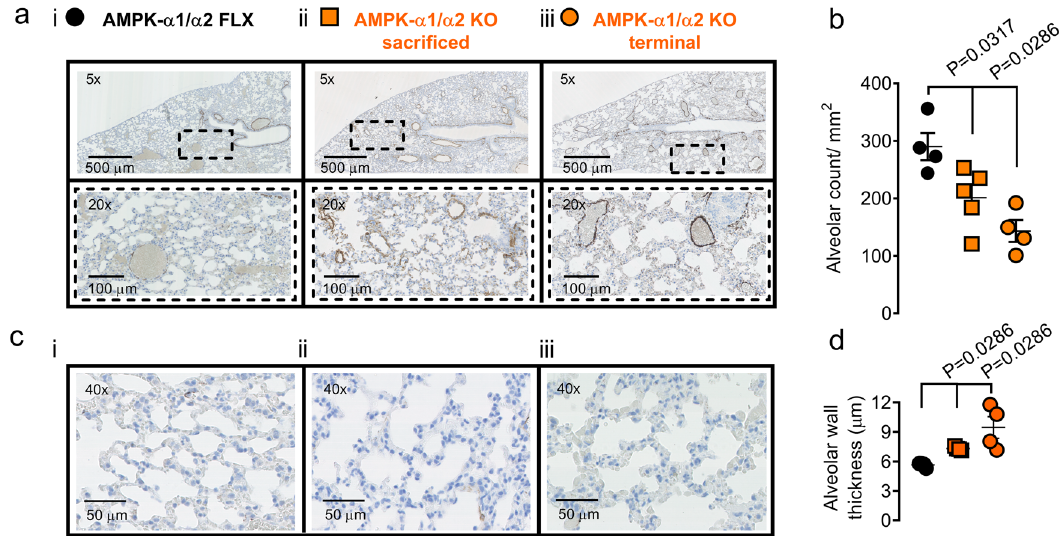
Fig. 4 | AMPK- α 1/ α 2 deletion reduces alveolar number and precipitates thick- ening of alveolar walls. a Representative images of alveoli in lung slices from terminal samples stained for α -smooth muscle actin. b Scatter plot shows alveolar numberpermm 2 forterminal( n =4mice)andnon-terminal( n =5mice)samplesof AMPK- α 1/ α 2 knockouts (AMPK- α 1/ α 2 KO) vs age-matched AMPK- α 1/ α 2 fl oxed controls (AMPK- α 1/ α 2 FLX; n =4 mice). The analysis in ( b ) was averaged from